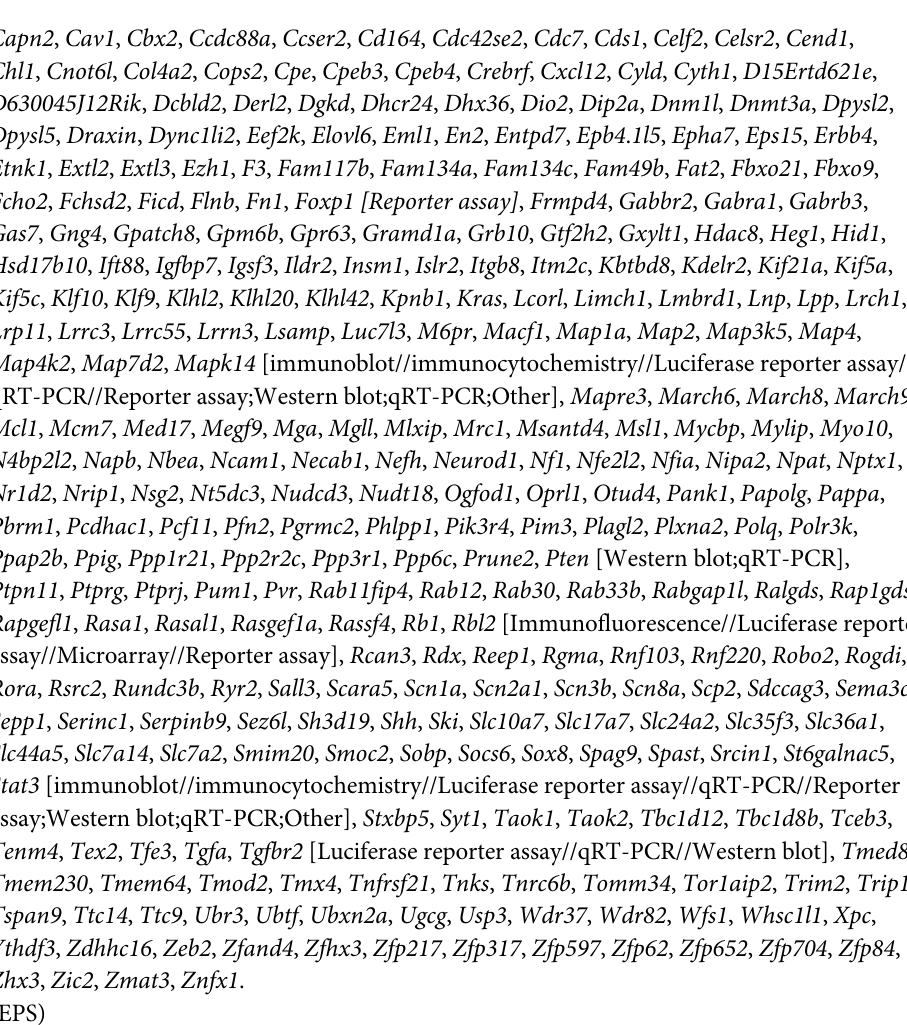
S3 Fig. Graphical representation of CpG densities and MBDseq reads averages among the gene classes. Estimation of CpG density and averages of methylation obtained in C57BL/6J controls for the genes “ other ” , “ miRNA ” , “ Olfr ” and “ vmn ” . Medians numbers were 48 CpG sites per promoter for genes that are not belonging to the three mentioned classes, 29 for microRNAs and 9 for both Vmn and Olfr promoters. Average reads number were approxi- mately 3 times more normalize reads within micro-RNAs promoters and 3 times less within Vmn/Olfr promoters compared to others. S4 Fig. Methylome, transcriptome and proteome in murine sperm. Plots illustrating devel- opmental expression of genes in mice sperm cell subtypes in function of both methylations in promoters of sperm DNA and proteins belonging to the mice sperm proteome. The methyla- tions levels were measured in the present study using MBD-seq data recorded in 2.2kb “ pro- moter ” probed regions in sperm cells extracted from the epididymis and the vas deferens of 8 weeks-old C57BL/6J controls mice. The genes expressions dataset of sperm cells subpopula- tions came from C57BL/6J males performed in a previous and independent work by Chalmel F et al 2007 using high-density oligonucleotide microarrays and 8 – 9 weeks-old mice for sper- matocyte and spermatid, and 4 – 8 days old mice for spermatogonium. Proteins were